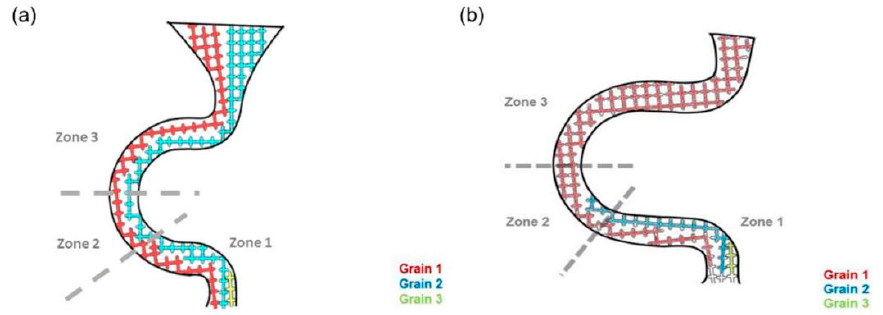
Figure 5. Grains (1, 2, 3) of geometrical blocking mechanism varying in pitch length: ( a ) 6 mm and ( b ) 8 mm.